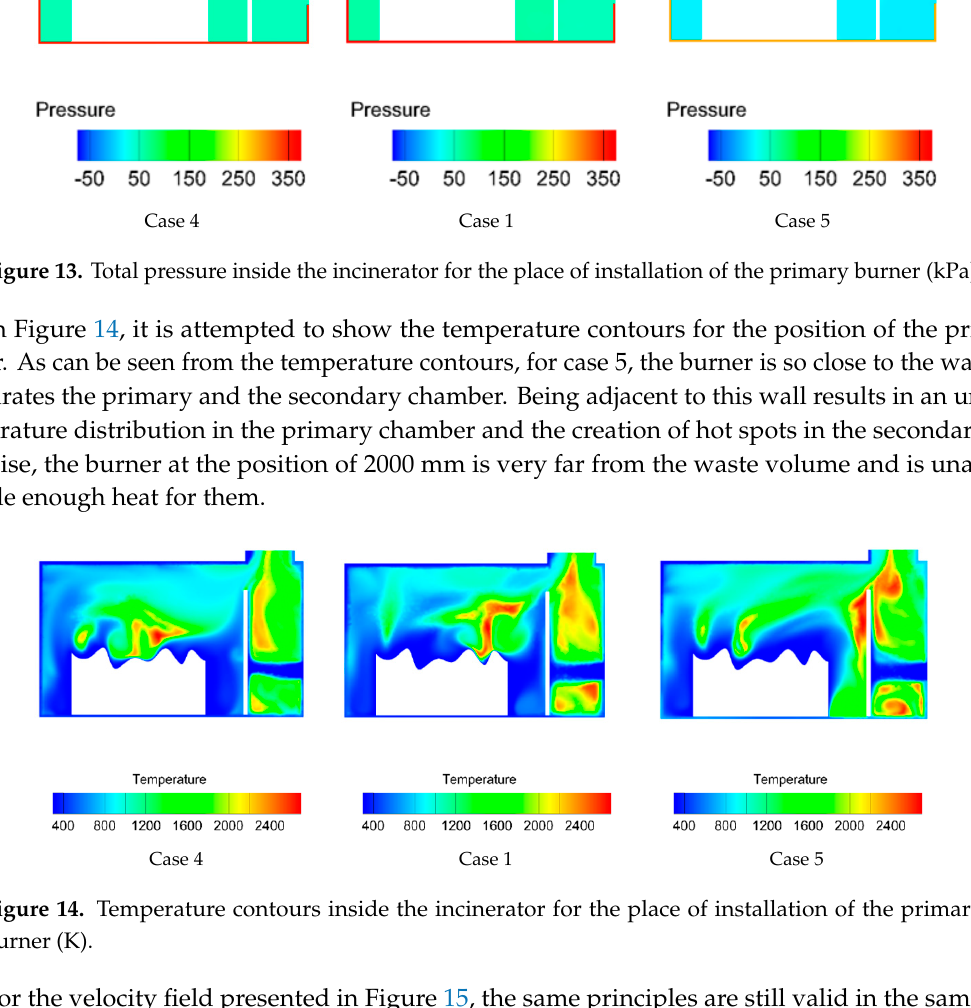
Figure 15. Velocity contours inside the incinerator for the place of installation of the primary burner (m/s).